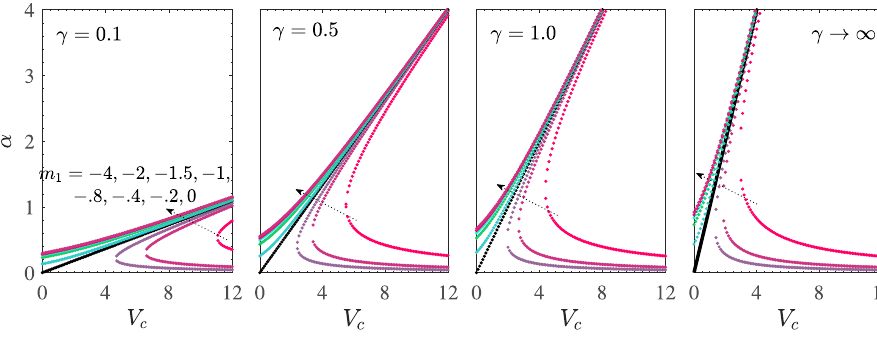
Fig 8. α vs V for γ 1 = 0.1 = − γ 2 and d = 1 + m 1 for the stretching sheet case with mass suction. Here, unique c solutions occur for m 1 � − 1 − M and the dual solutions occur for m 1 > − 1 − M .